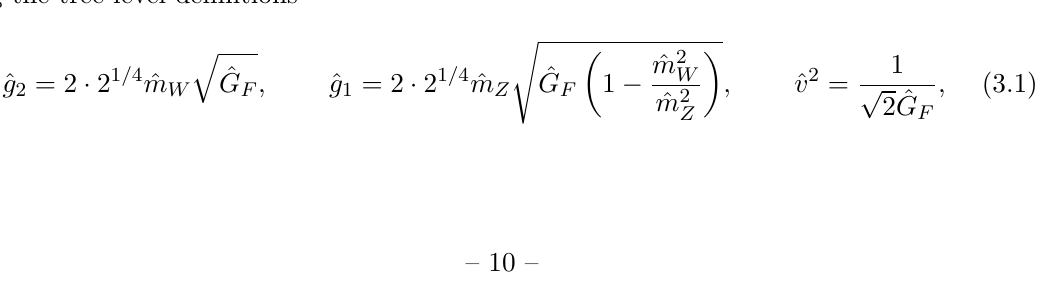
Figure 1 . Sample diagram topologies for (cid:22) with charged